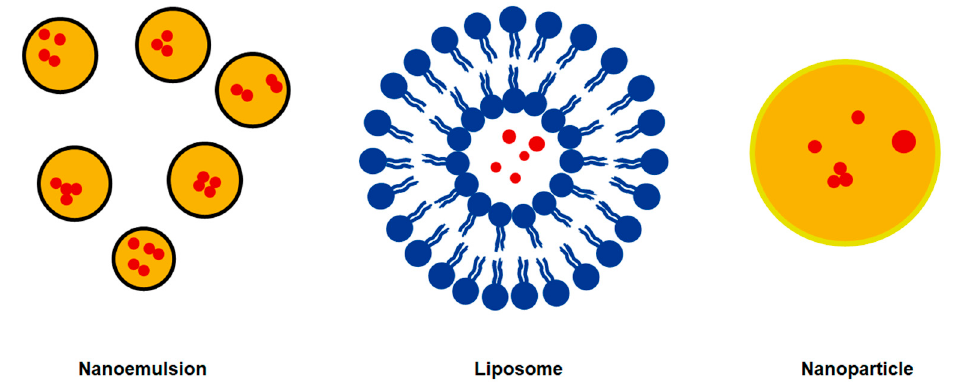
Figure 3. Three typical delivery